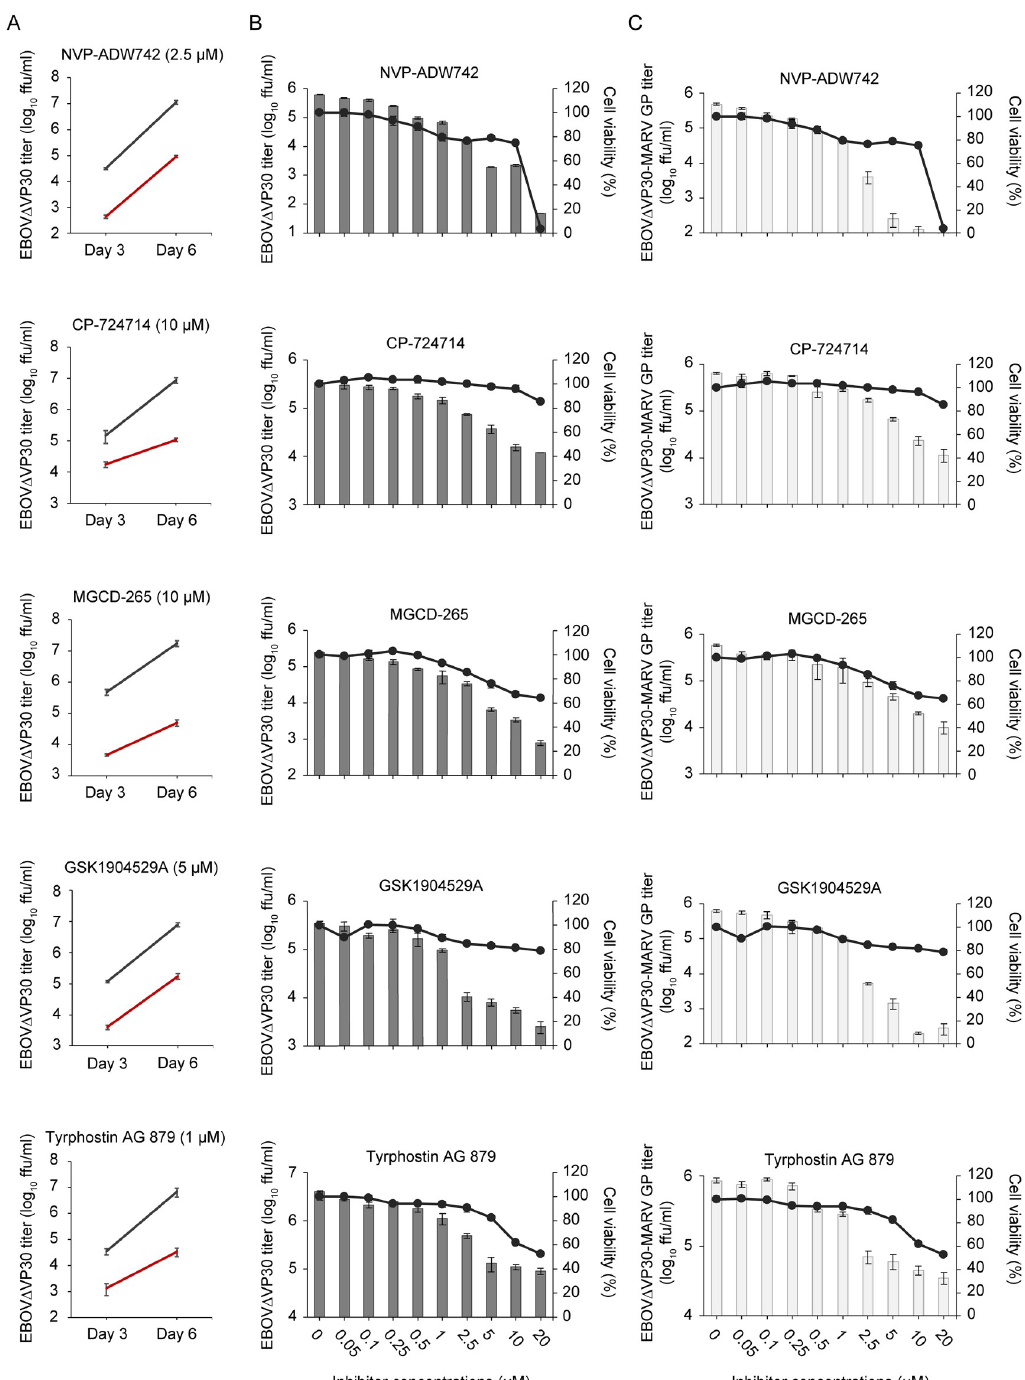
Fig 1. Identification of RTK inhibitors that attenuate EBOV GP- and MARV GP-mediated virus growth. (A) Titers of EBOV Δ VP30-GFP from Vero VP30 cells in the presence of RTK inhibitors. Cells were treated with each RTK inhibitor at the indicated concentration (red line) or with 0.5% DMSO (black line) for 4 h prior to infection with EBOV Δ VP30 at an MOI of 0.01. Virus titers were determined on days 3 and 6 post-infection. Data are presented as means ± SD of three independent experiments. (B and C) Virus titers (shown as bars) from Huh7.0 VP30 cells in the presence of RTK inhibitors. Cells were treated with the increasing doses of RTK inhibitors or with 0.5% DMSO for 4 h prior to infection with EBOV Δ VP30 (B) or EBOV Δ VP30-MARV GP (C) at an MOI of 0.01. Virus titers were determined on day 3 post-infection. In a separate set of experiments, viability of cells (shown as continuous lines) after treatment with inhibitors for 3 days was measured by means of a cell viability assay. Data are presented as means ± SD, and are representative of experiments performed in triplicate and repeated twice.